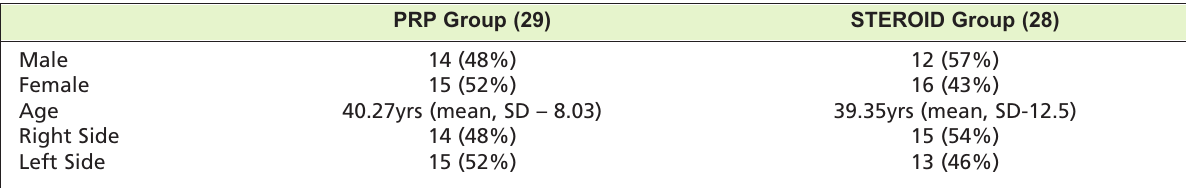
Comparison of the characteristics of both groups Table I: